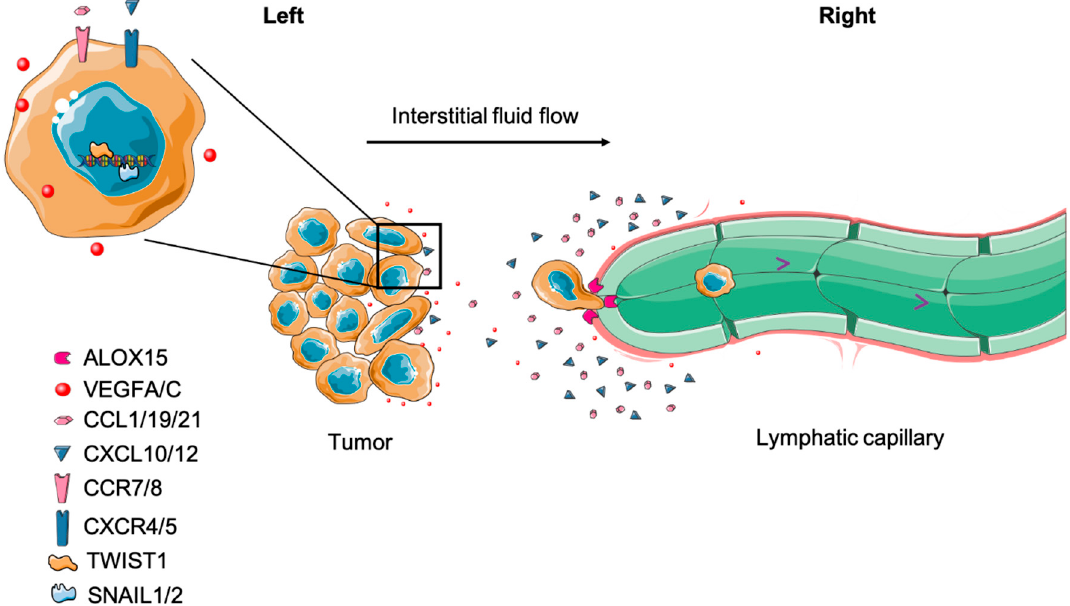
Figure 1. Cancer cells migrate and invade lymphatic vessels. ( Left ) Primary tumor cancer cells release VEGF A/C to promote local lymphangiogenesis. Cancer cells also undergo EMT to increase their invasiveness. In addition, they can upregulate CCR7/8 and CXCR4/5 expression, enabling their responsiveness to the corresponding ligands, CCL1/19/21 and CXCL10/12, respectively. ( Right ) In response to these stimuli, cancer cells migrate to lymphatic vessels through chemotaxis. Some cancer cells express ALOX15, which catalyzes arachidonic acid to 12[S]-HETE and 15[S]-HETE. Accumulation of these metabolites causes circular defects on lymphatic endothelium, facilitating cancer cell entrance. Of note, interstitial fluid flow not only mechanically contributes to cancer cell migration to lymphatic vessels but also assists cancer cells to produce and follow autocrine chemokine gradients to lymphatic vessels.